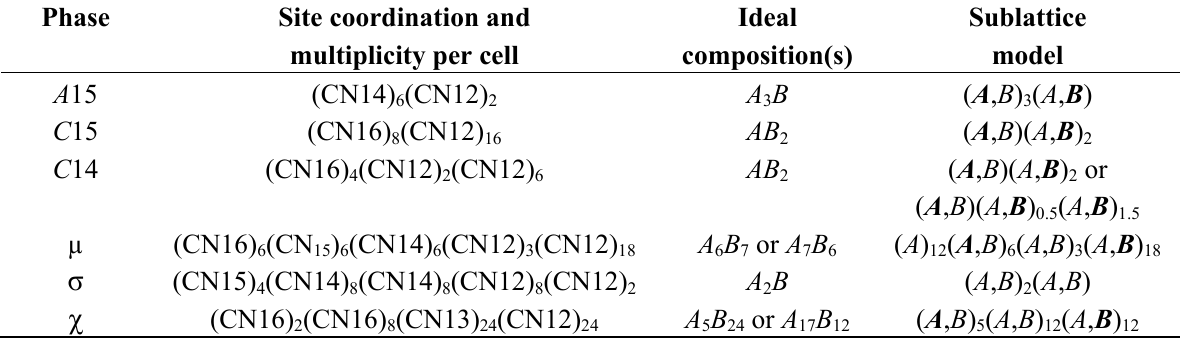
Table 1. Proposed Calphad sublattice models for selected FK phases issued from crystallographic analysis. Bold characters indicate the major element, if